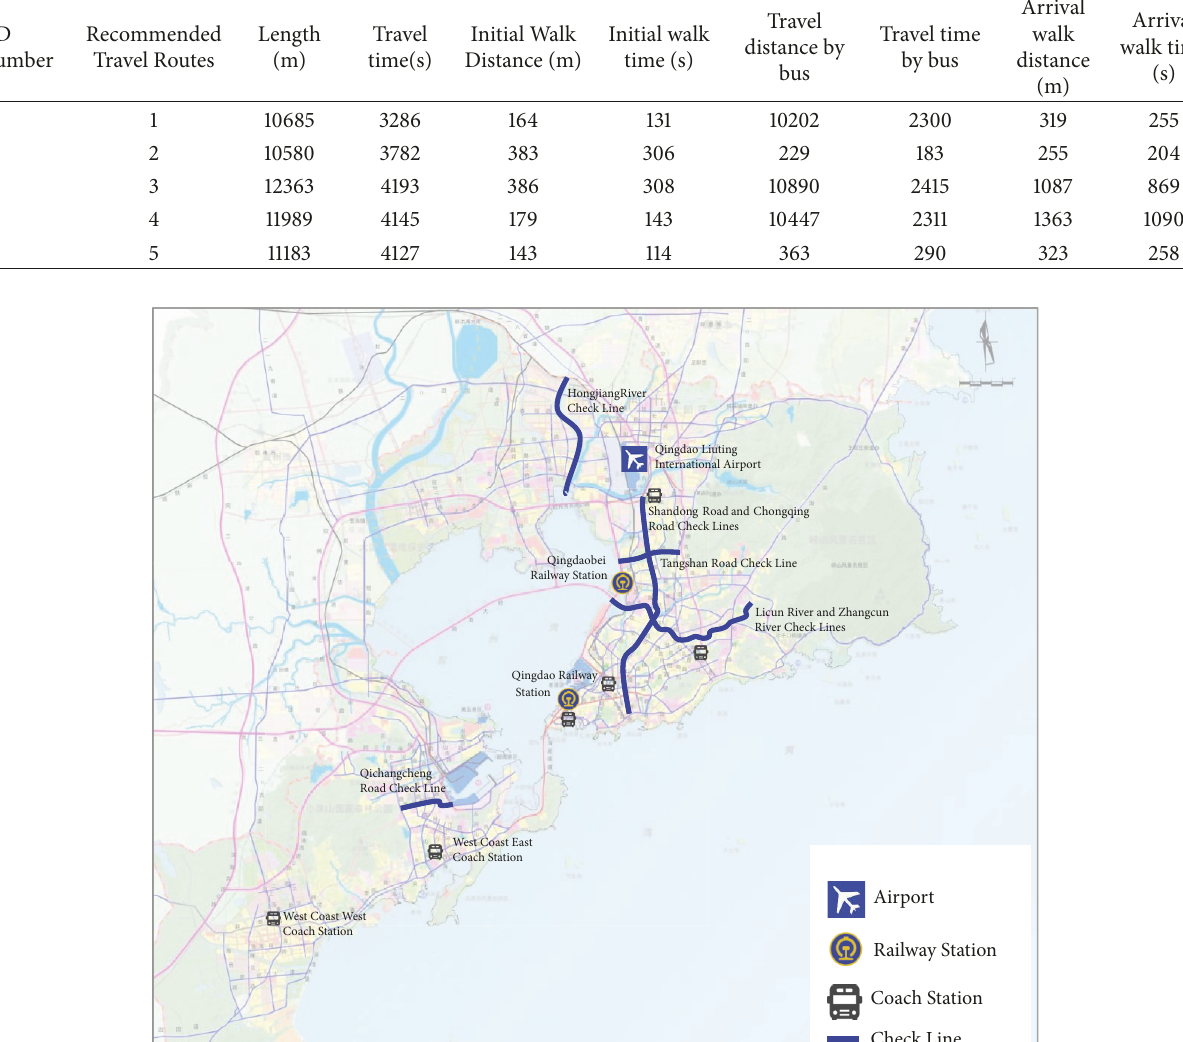
Table 3: Data sample of Baidu Maps Web API v2.0.